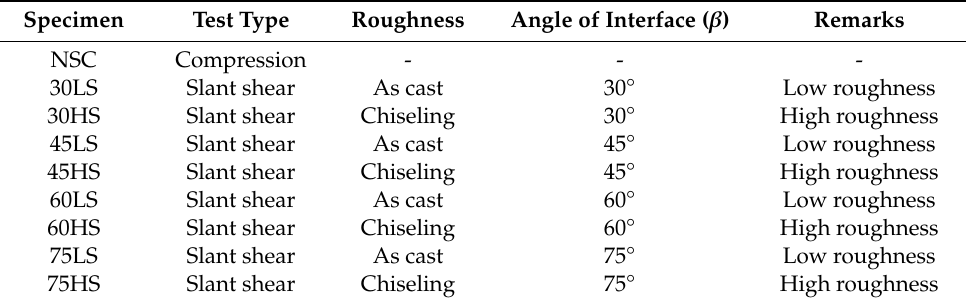
Table 6. Summary of slant shear test specimens.